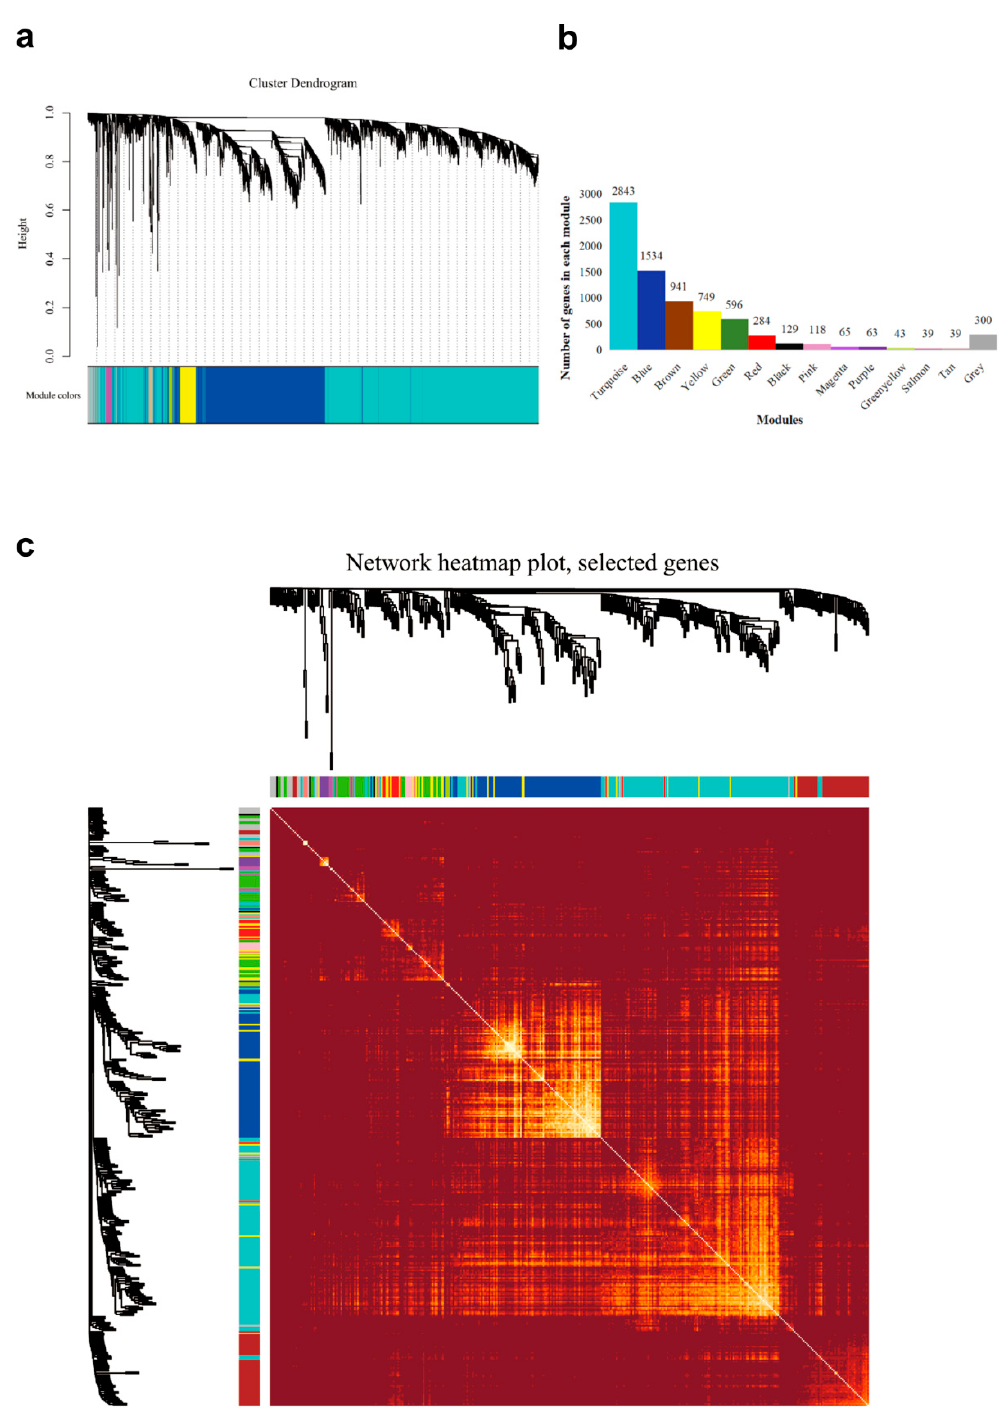
Figure 6. Plot of WGCNA. ( a ) Dynamic tree cut based on a topological overlap measurement. ( b ) Number of genes in each module. ( c ) Network heatmap plot of randomly selected 400 targets. Each row and column represent a module and the genes of the module. Stronger correlations are indicated by progressive saturation in yellow.